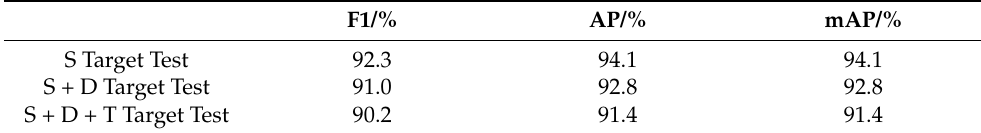
Table 2. Test set accuracy of the model for different numbers of targets.